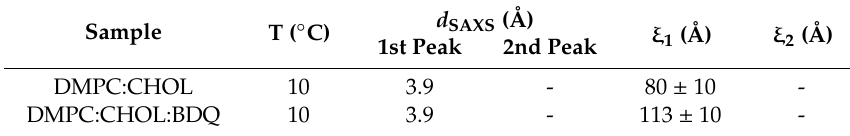
Table 4. WAXS di ff raction patterns of DMPC:CHOL and DMPC:CHOL with BDQ at 5% molar ratio at 10 ◦